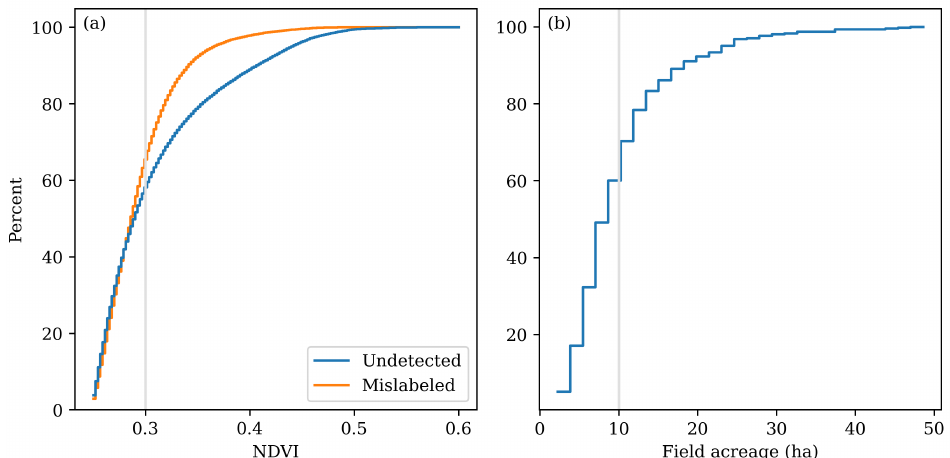
Figure 7. Distributions of ( a ) NDVI values for center-pivot fields (CPFs) not detected by the frame- work (fields in Table 3; row 8) and CPFs mislabeled as non-CPFs (mislabeled, fields in Table 3; row 7), and ( b ) field acreages of mislabeled CPFs being detected as non-CPFs. Non-CPFs indicated fields showing rectangle